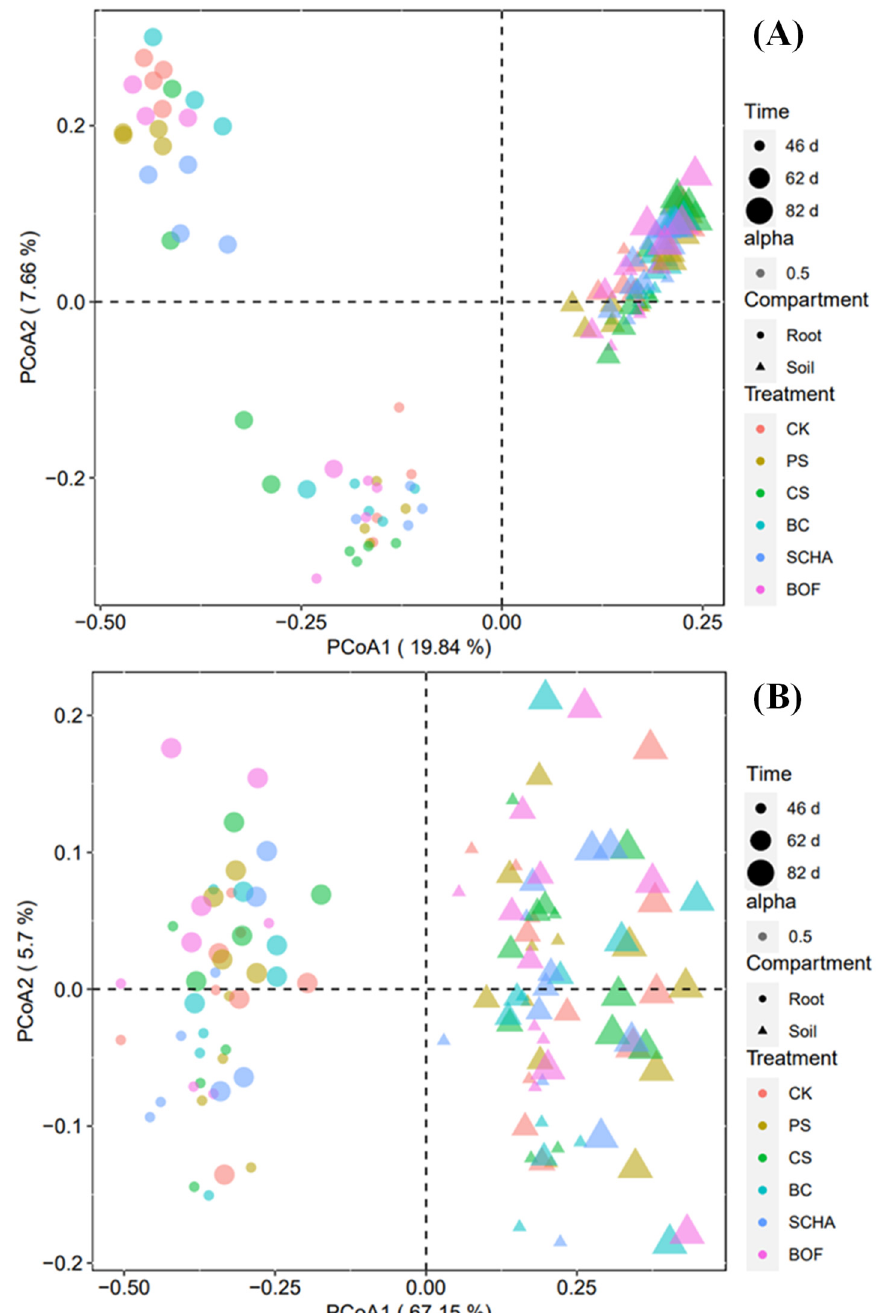
Figure 4. Principal component analysis (PCOA) of the soil and root bacterial community ( A ) and fungal community ( B ) structure between different treatments at different periods ( n = 4). Amendment treatments include CK (no fertilization); PS (potassium silicate); CS (calcium silicate); BC (biochar); SCHA (calcium silicate humic acid); BOF (bio-organic